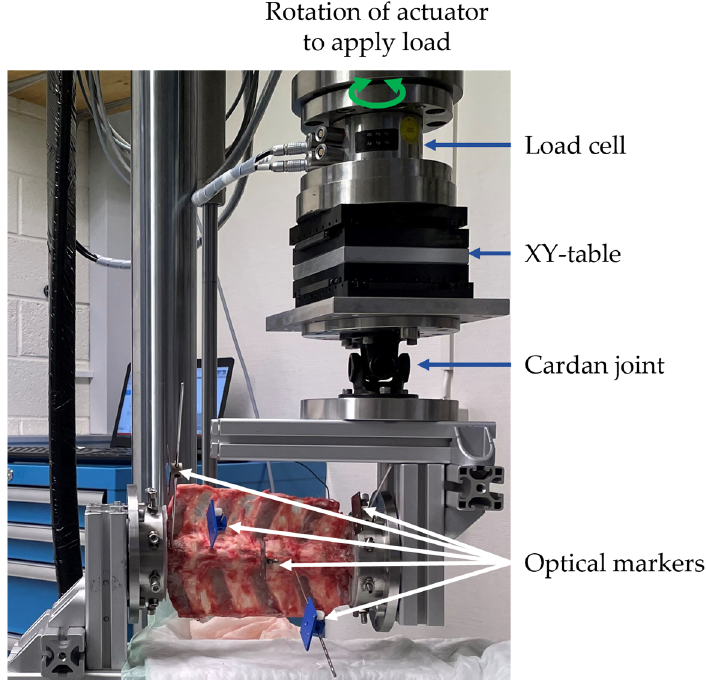
Figure 3. Test setup for unconstrained flexion-extension loading.